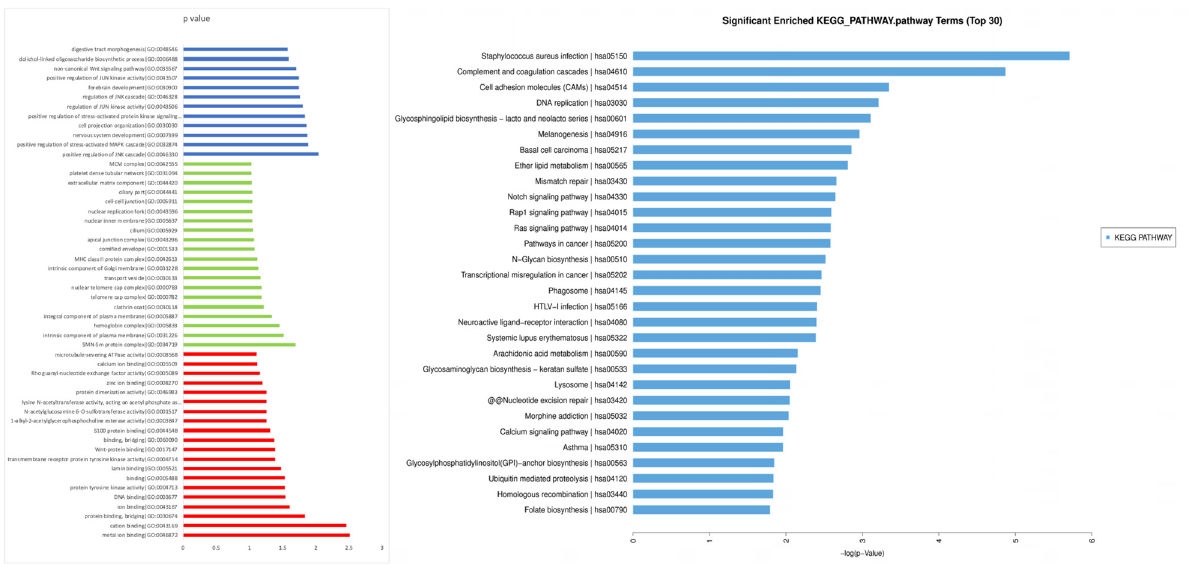
Figure 3: GO analysis of the predicted mRNA target genes. Data are presented as a histogram of the relevant biological processes, cellular components, and molecular functions identi fi ed. KEGG pathway analysis of predicted mRNA is presented as a potential pathway.